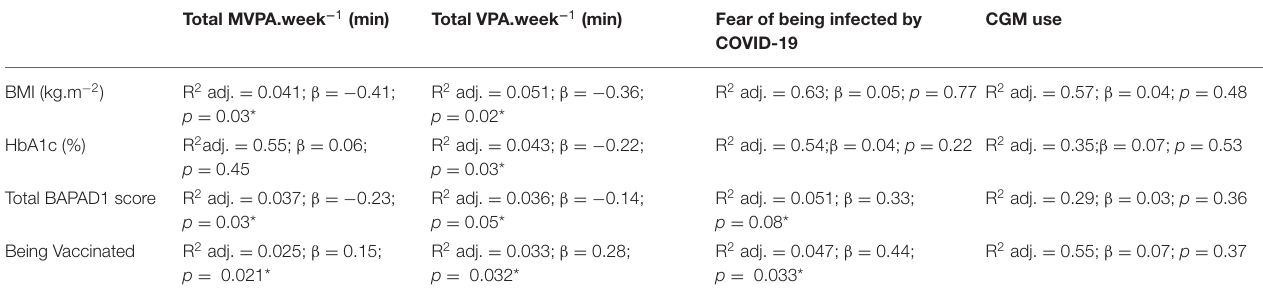
TABLE 2 | Standardized regression summary for physical activity time per week, being vaccinated, fear of being infected by COVID-19 and CGM use with other relevant